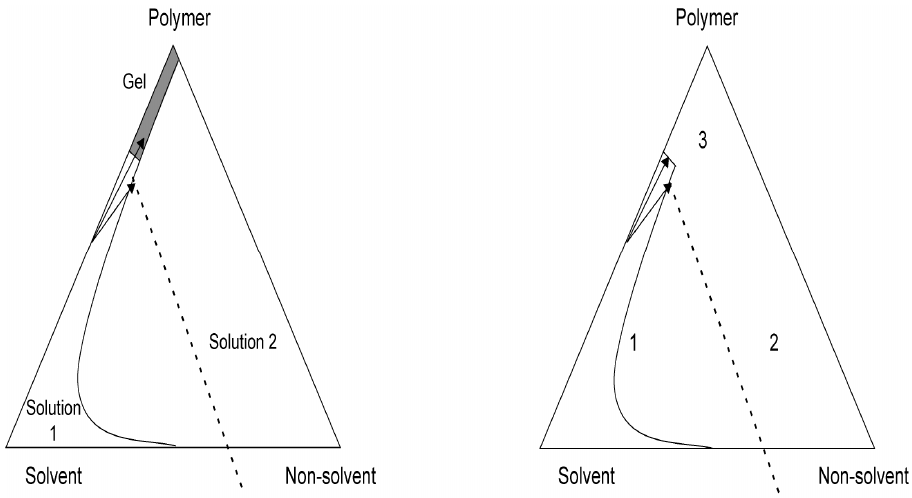
Figure 6. Phase diagram for the phase-inversion process.